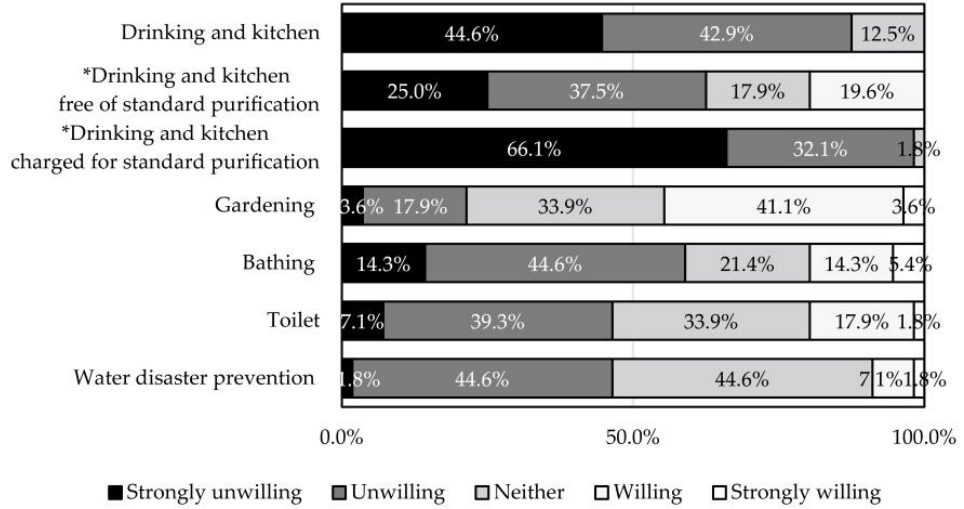
Figure 8. Acceptable water consumption activities of water cellars complementary to piped water ( n = 56). * Hypothetical